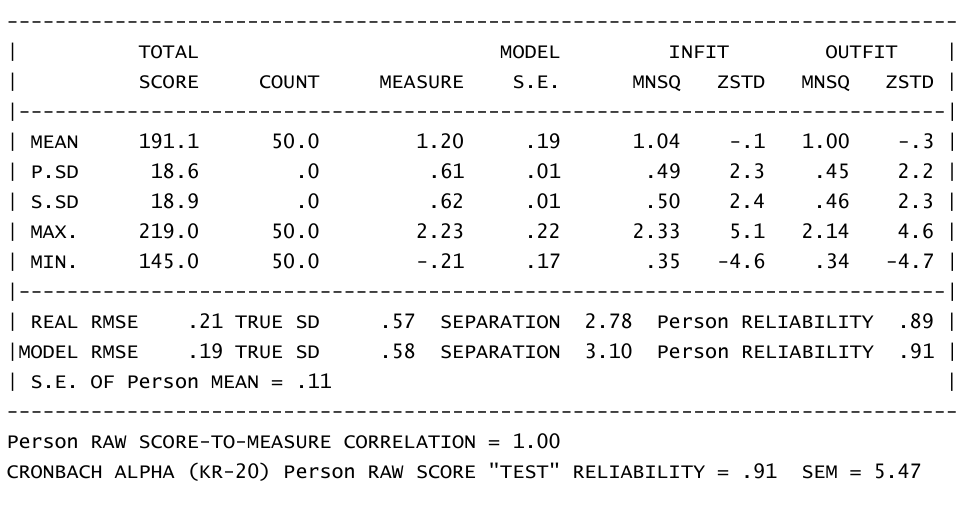
Table 4. Summary of 50 Measured Item